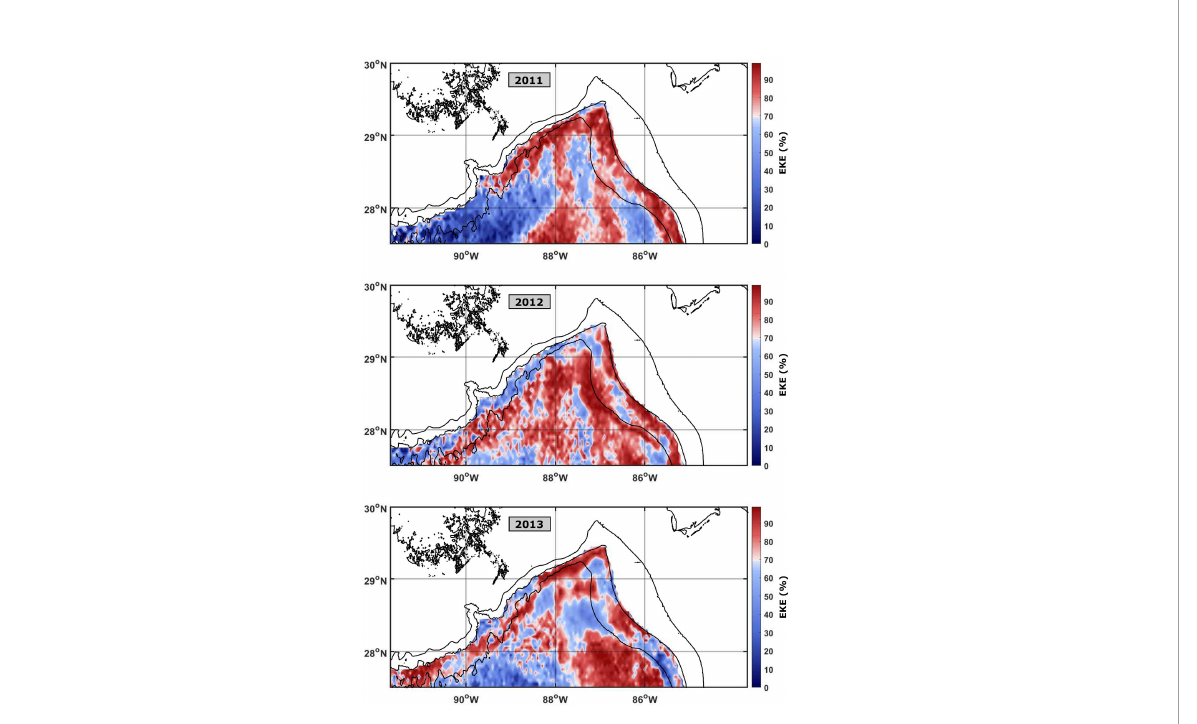
FIGURE 5 Ratio of EKE to total kinetic energy (EKE+MKE) in each grid cell, represented as a percentage for 2011 (top), 2012 (middle), and 2013 (bottom) in the northeastern GoM. EKE and MKE are calculated from virtual particle velocities binned in a 0.05° × 0.05° geographical grid, for each year separately. Isobath is shown in black.